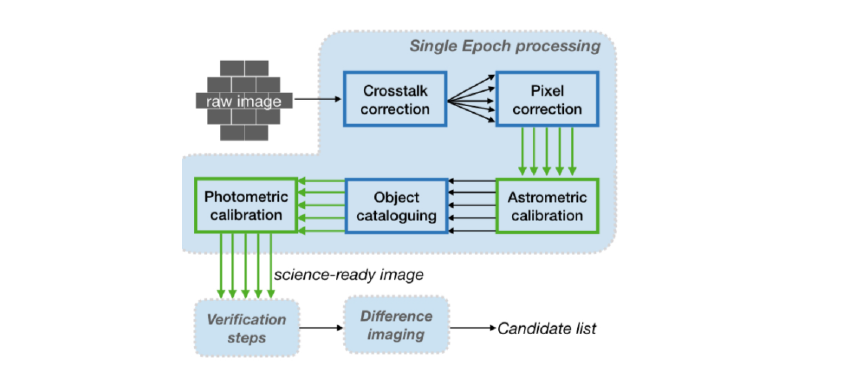
Figure 2. Diagram of the updated single-epoch processing pipeline. Green arrows indicate steps that were previously performed on all CCDs simultaneously and are now fully parallel per CCD in the updated O3